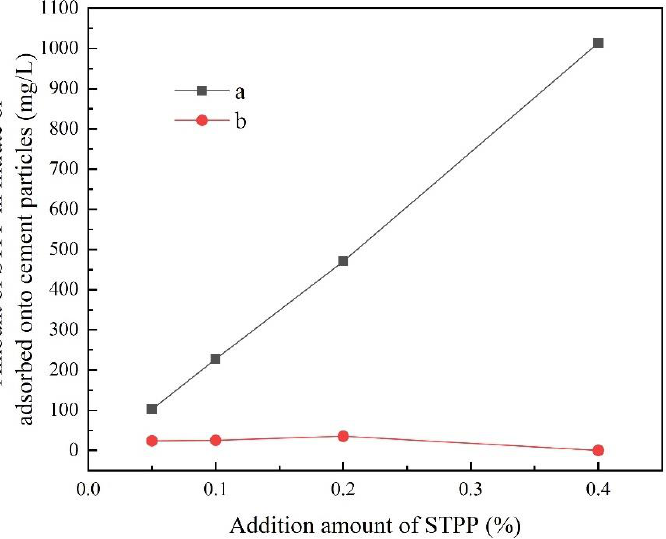
Figure 1. Amount of STPP in the filtrate after 10 min of stirring (a) and adsorbed onto cement particles after 10 min of stirring (b).